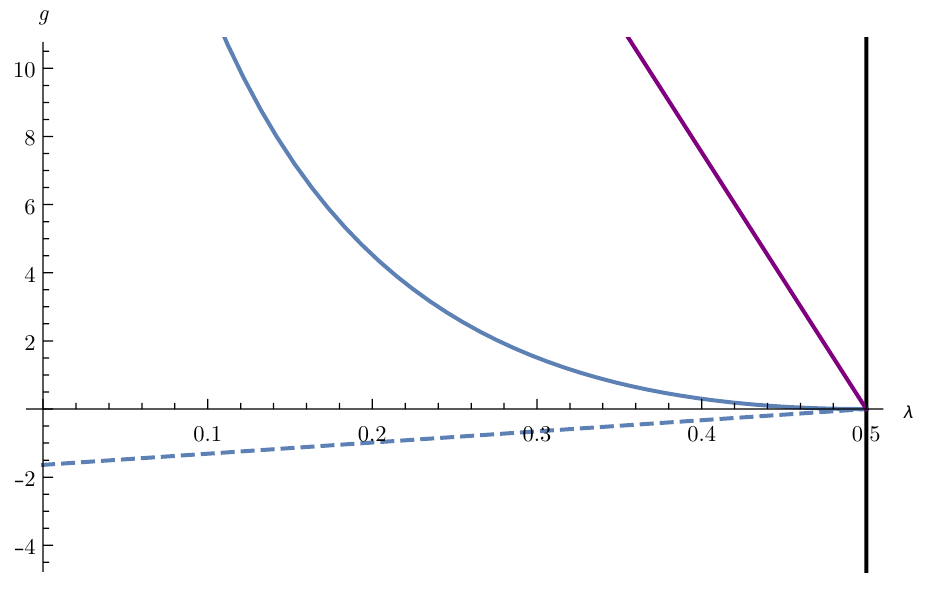
Figure 2 . Illustration of the singularity structure of the beta functions (3.14), (3.15), (3.19) and (3.21) projected onto the y = 0-plane. The black line indicates the (cid:12)xed singularity at (cid:21) sing = 1 = 2. At the blue and purple lines the anomalous dimensions (cid:17) N and (cid:17) s diverge respectively. The solid lines apply to the Type I regulator while the dashed result is obtained from the Type II regularization